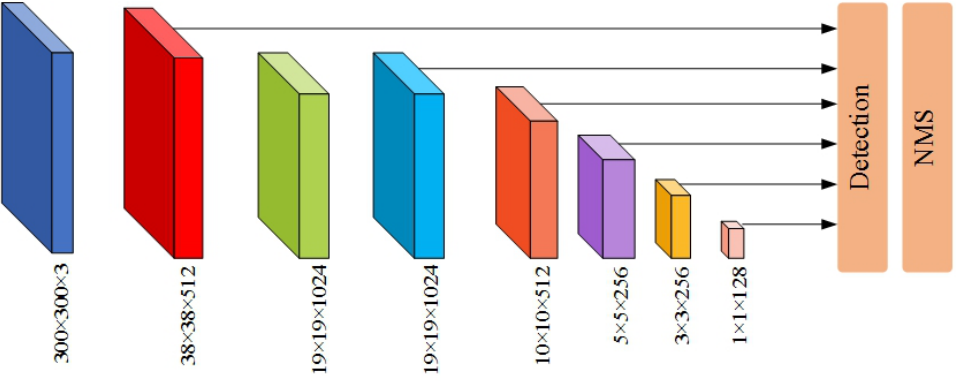
Figure 5. Structure of the SSD model.